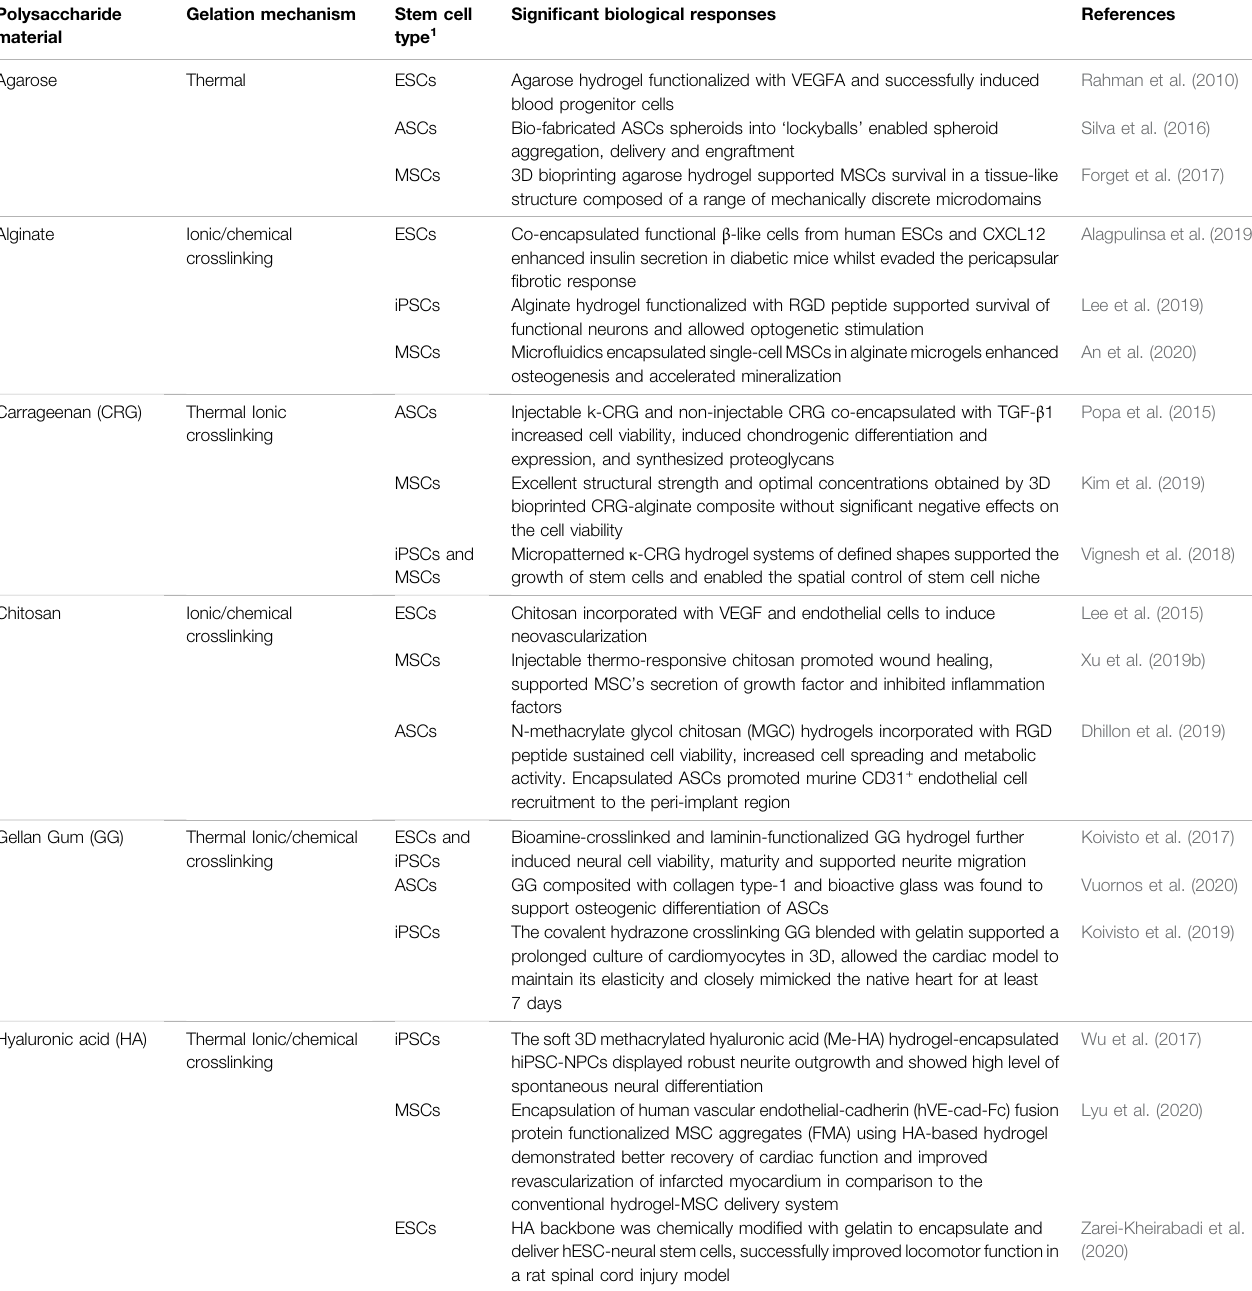
TABLE 1 | Polysaccharides derived natural hydrogels microencapsulated with different type of stem cells and their